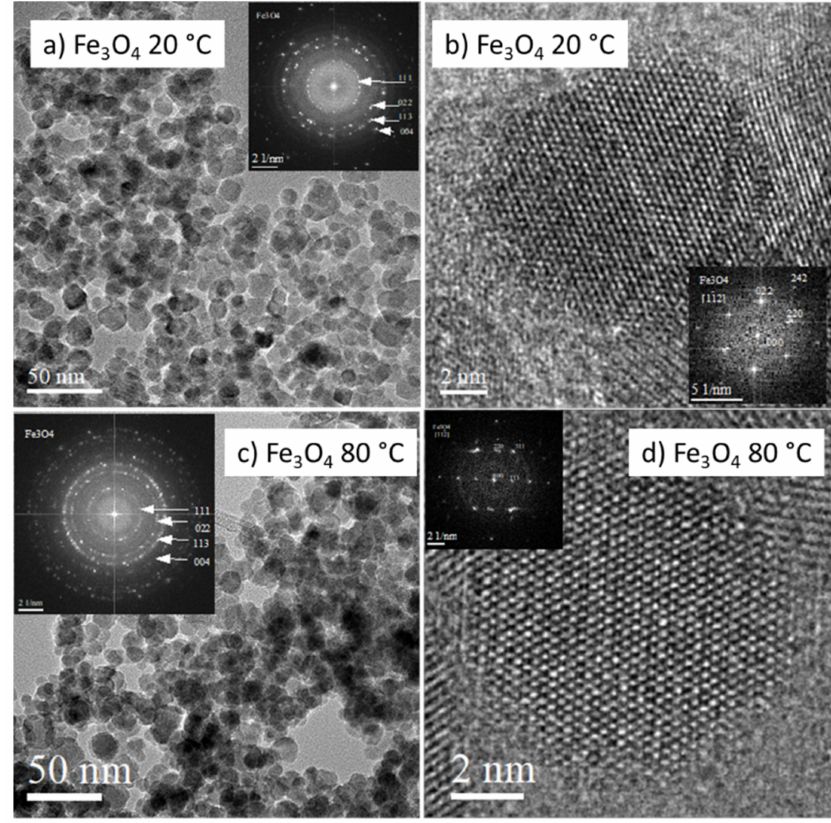
Figure 1. Microstructure of naked Fe 3 O 4 NPs prepared at 20 ◦ C ( a , b ) and 80 ◦ C ( c , d ), respectively. Low-magnification TEM images of NPs with relevant SAED pattern in insets ( a , c ). HRTEM/ARTEM images of individual NPs with relevant FFT patterns in insets ( b , d